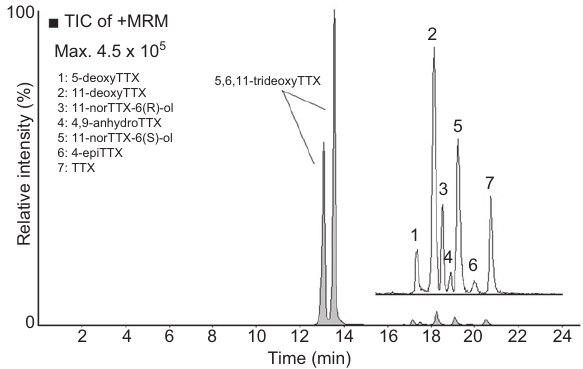
Figure 2 Mass chromatogram of the LC-ESI-CID-MS/MS obtained under MRM operation from the puffer fish sample. Toxins eluted in an XBridge Amide column (i.d. 2.1 × 150 mm; 3.5 μ m) at 25 ° C, 0.2 ml/min. The LC was operated in gradient with eluent A consisting of 10 m m ammonium formate and 10 m m formic acid in water. Eluent B contained 95 % acetonitrile and 5 % water with a final concentration of 5 m m ammonium formate and 2 m m formic acid. Minutes 16 to 22 represent a broadening of the chromatogram where the toxins are eluted. CID, collision-induced dissociation; ESI, electrospray ionisation; i.d., inner diameter; LC, liquid chromatography; MRM, multiple reaction monitoring; MS, mass spectrometry; TIC, total ion chromatogram.